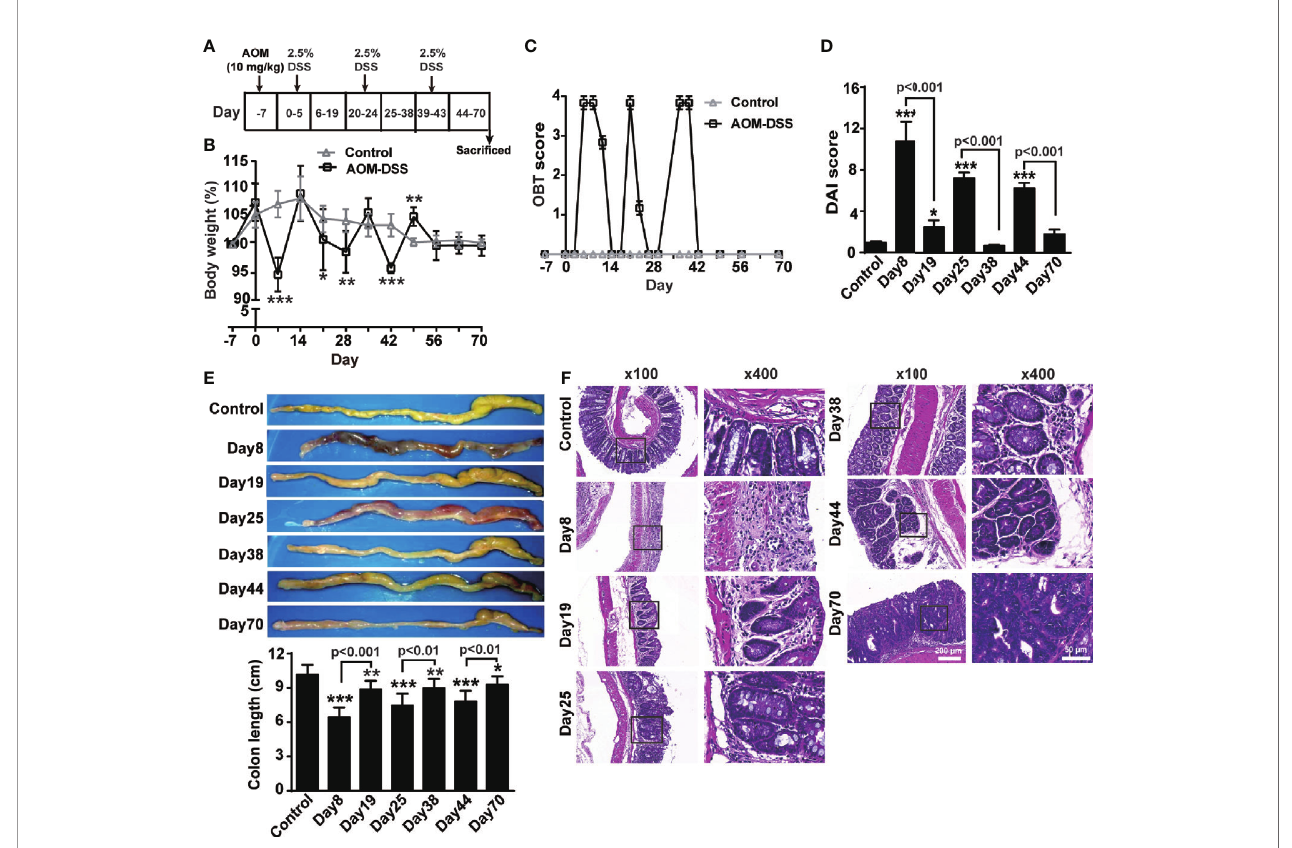
FIGURE 1 | AOM/DSS induced CAC. (A) Schematic treatment of mice with AOM and DSS. Mice were intraperitoneally administered with AOM (10 mg/Kg) at day -7, followed by three cycles of drinking 2.5% DSS-containing water for 5 days with interval of 14 days (n = 6, each group). Time course for body weight (B) , score of occult blood test (OBT) (C) and disease activity index (DAI) (D) . (E) Representative images and quantitative data of colon length. (F) Colons tissue sections were stained with hematoxylin and eosin. Representative histopathological images (×100, ×400). All quantitative data are expressed as means ± SEM. *P < 0.05, **P < 0.01, ***P < 0.001 versus